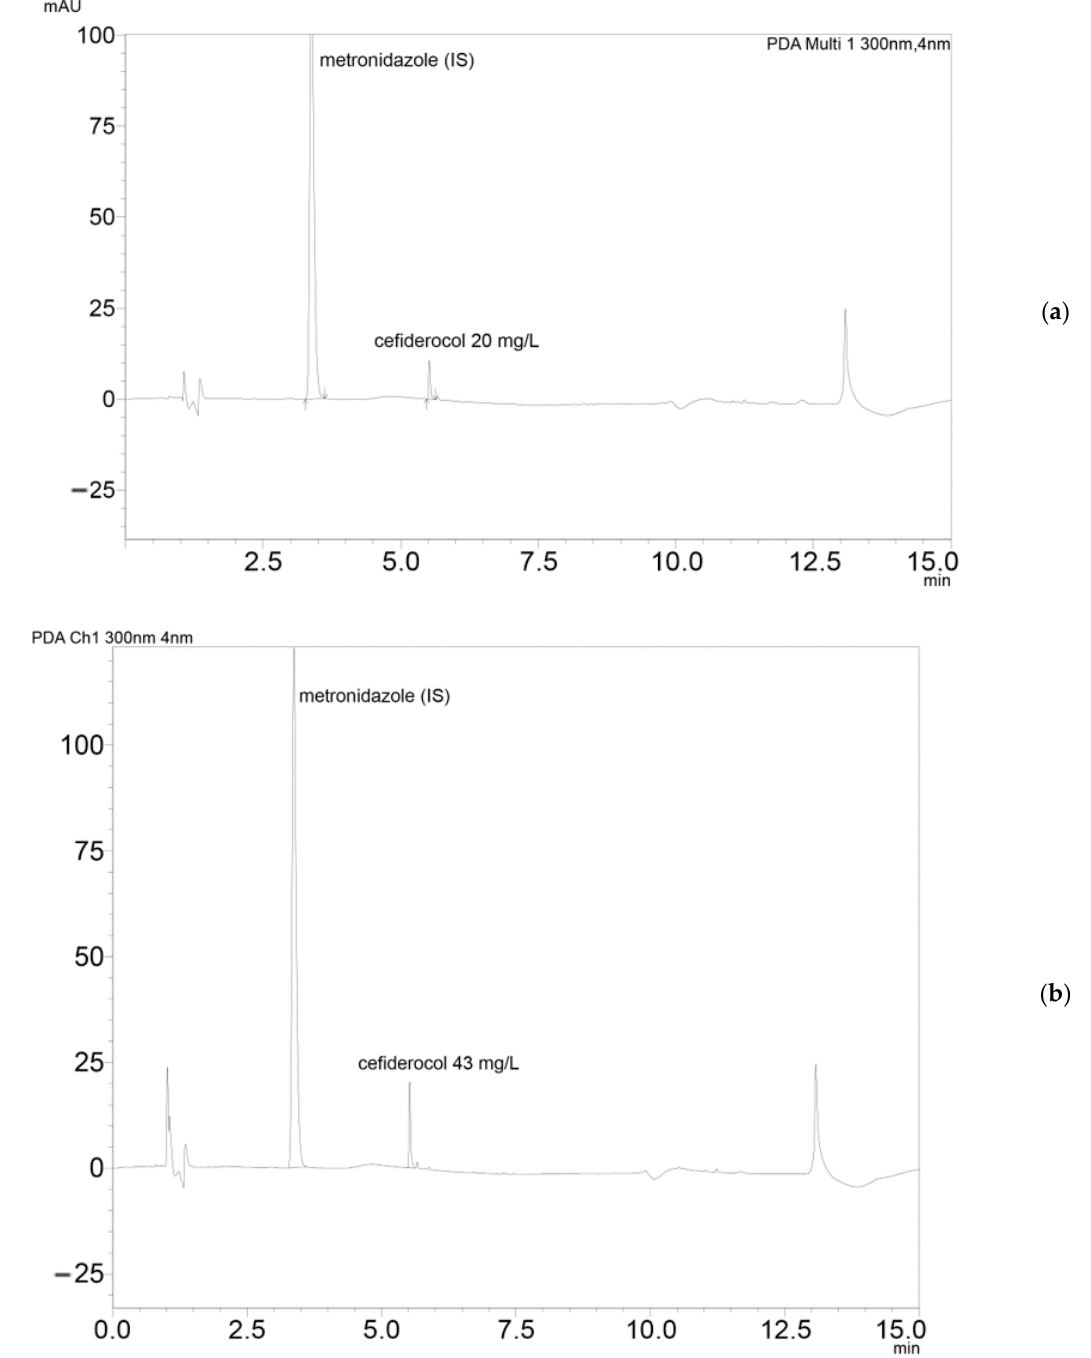
Figure 4. ( a ) Chromatogram of cefiderocol calibration standard concentration (20 mg/L) and ( b ) chromatogram of cefiderocol in patient